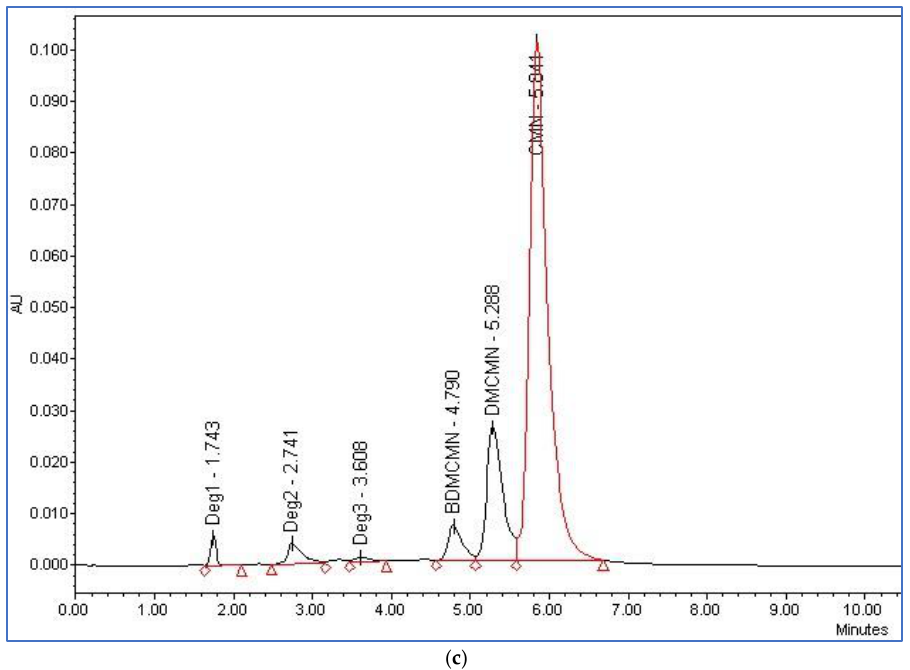
Figure 7. HPLC chromatograms of curcuminoids, ( a ) after exposure to acid degradation; ( b ) after exposure to base degradation; ( c ) after exposure to thermal degradation.